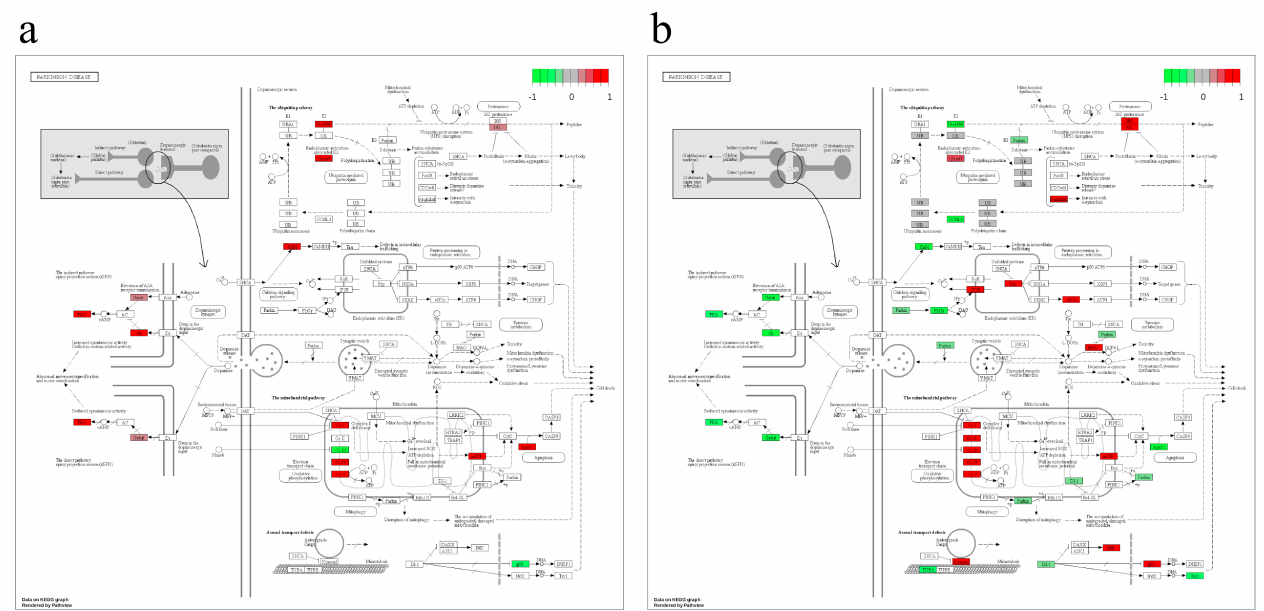
Figure 7. Graphical visualization of the KEGG pathway DEGs (Parkinson’s disease) was found to be associated with ( a ) rs16910241 and ( b ) rs56119169 variants in this study.KEGG pathway diagrams show the genes grouped in different functional units distributed along the pathway. Gene node colors show the direction of the change in